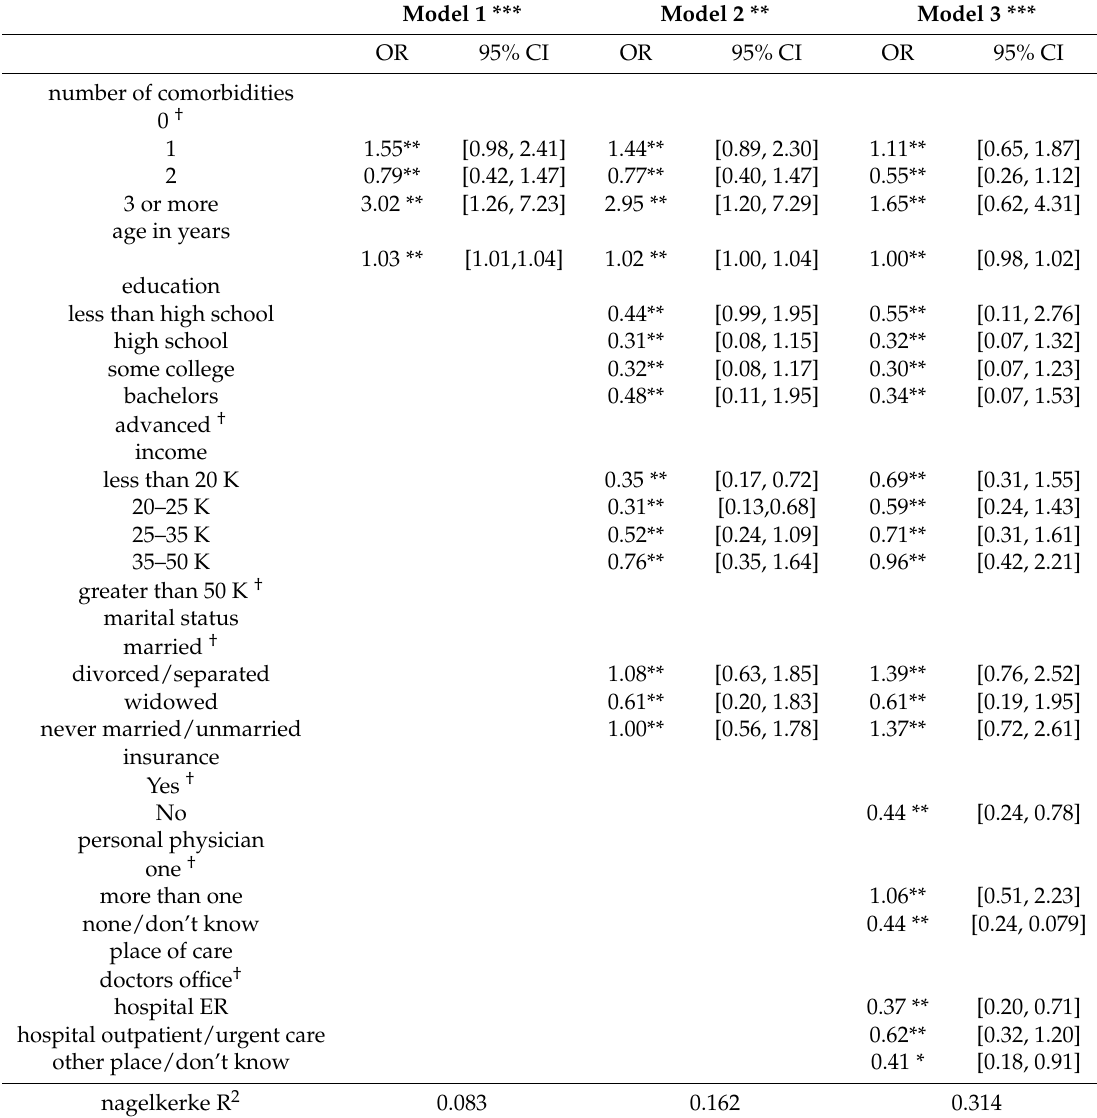
Table 3. Nested Binary Logistic Regression Predictive of Patient Ability to Get Questions